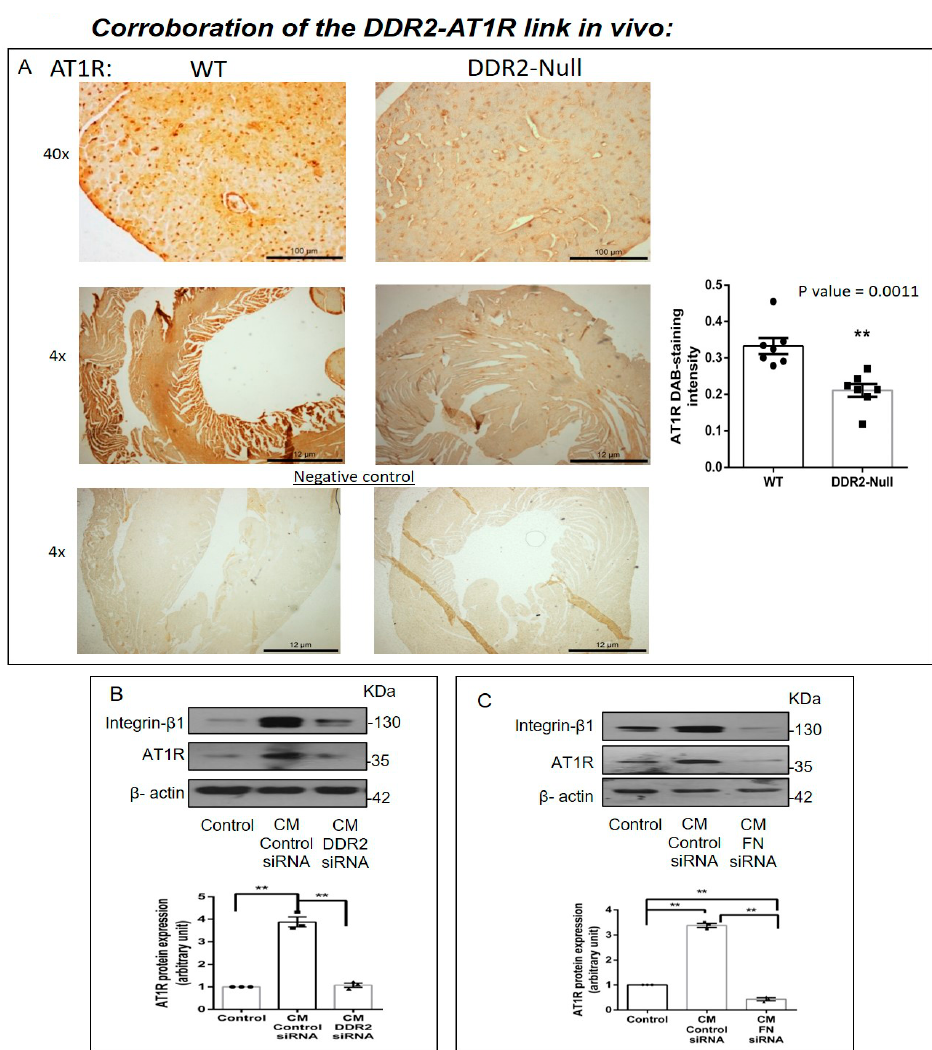
Figure 6. Corroboration of the DDR2-AT1R link in vivo . ( A ) Representative image showing 3,3 ′ -diaminobenzidine (DAB) staining of AT1R protein in myocardial tissue sections of 10-week-old WT and DDR2-null mice. ** p < 0.01 versus WT (n = 7). ( B ) Sub-confluent quiescent cultures of H9c2 cells were treated for 24 h with conditioned medium (CM) derived from control siRNA-treated cardiac fibroblasts or DDR2-silenced cardiac fibroblasts. Quiescent cultures of H9c2 in M199 without serum were used as the control for basal AT1R protein expression in these cells. AT1R protein expression in H9c2 cells was examined by Western blot analysis and normalized to β -actin. ** p < 0.01 (comparisons as depicted in the Figure), (n = 3, for the conditioned medium experiments, cardiac fibroblasts were from three isolations from three rats). ( C ) Sub-confluent quiescent cultures of H9c2 cells were treated for 24 h with conditioned medium (CM) derived from control siRNA-treated cardiac fibroblasts or fibronectin (FN)-silenced cardiac fibroblasts. Quiescent cultures of H9c2 in M199 without serum were used as the control for basal AT1R protein expression in H9c2 cells. AT1R protein expression was examined by Western blot analysis and normalized to β -actin. ** p < 0.01 (comparisons as depicted in the Figure), (n = 3, for the conditioned medium experiments, cardiac fibroblasts were from three isolations from three rats).